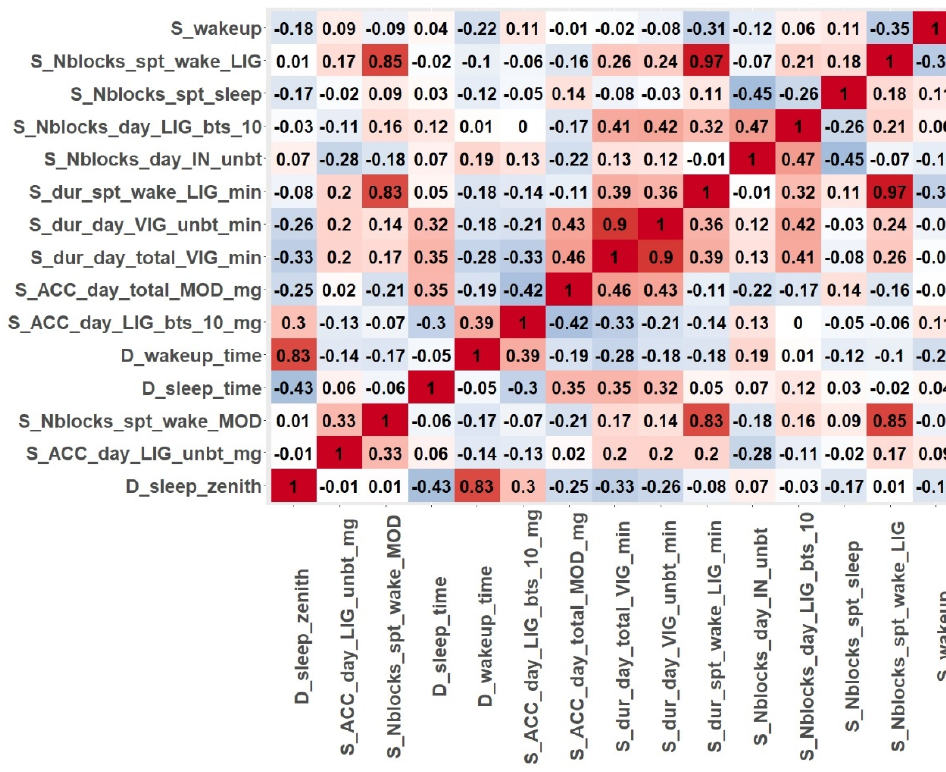
Figure 2. Correlation matrix for the features selected for patient P07.